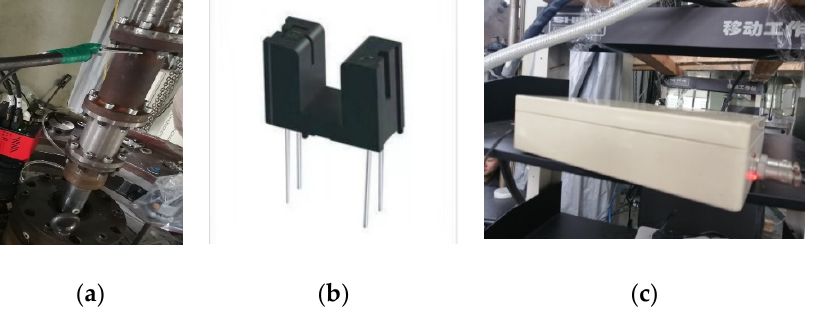
Figure 4. Shooting trigger device: ( a ) optocoupler phase lock trigger; ( b ) optocoupler; ( c ) trigger controller.